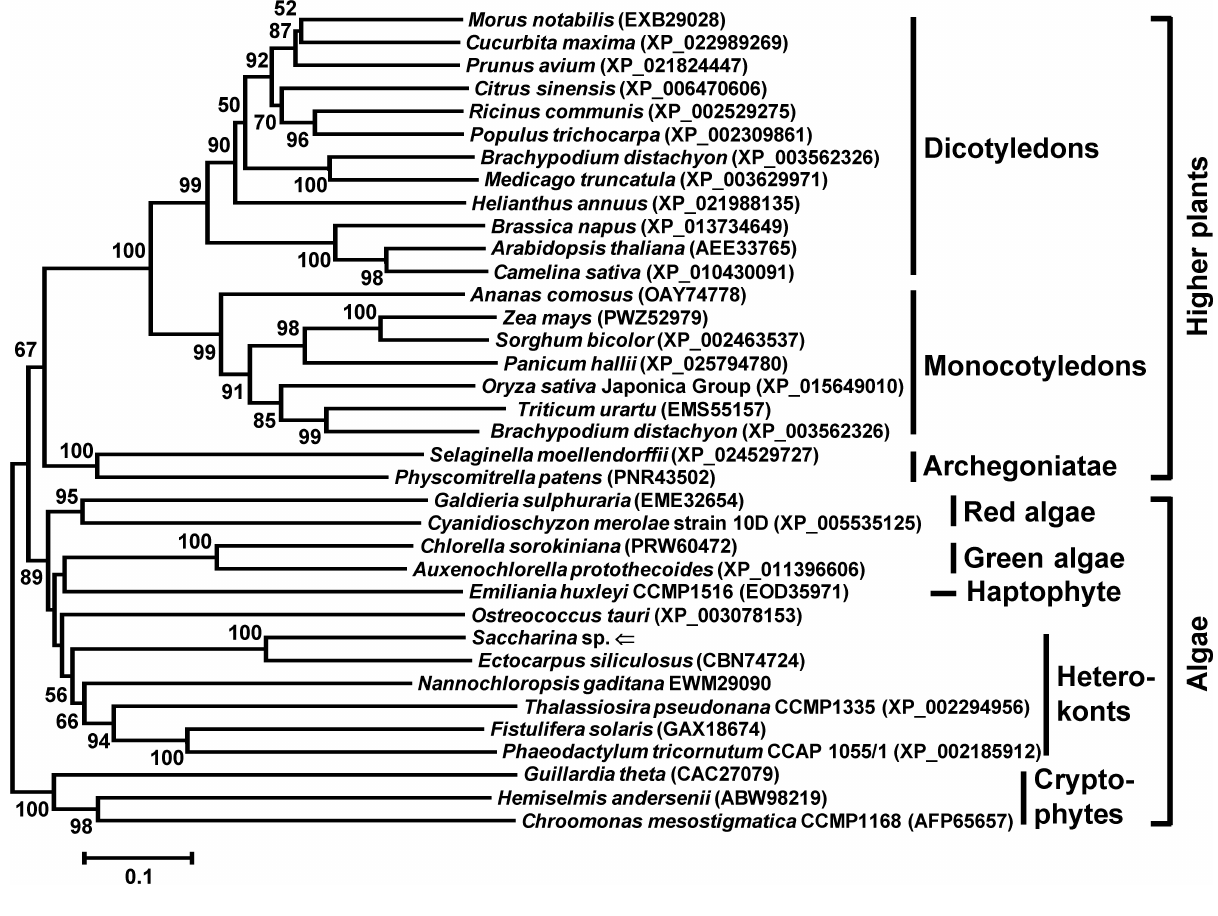
FIGURE 2 | Neighbor-joining phylogenetic tree inferred from the deduced amino acid sequences of Nuf2 genes from different species of organisms. This phylogenetic tree was reconstructed by 279 amino acids after removal of gaps by hand. All of the accession numbers are presented in parentheses after the Latin names. Branch lengths are proportional to the number of substitutions per site (see the scale bar). The numbers at the nodes indicate the neighbor-joining bootstrap values (BV) (only values ≥ 50% are shown). The Nuf2p from the Saccharina cultivar is marked by an